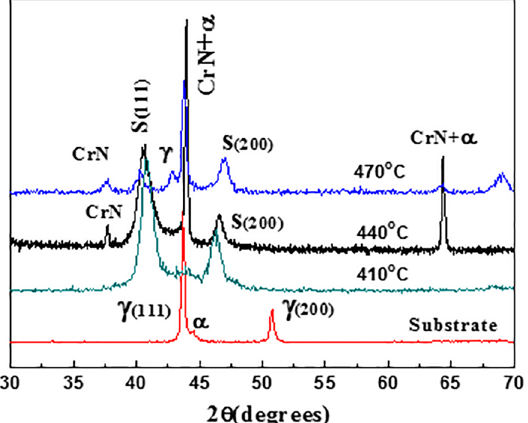
Figure 2 . XRD patterns of the untreated and oxy-nitrided samples.